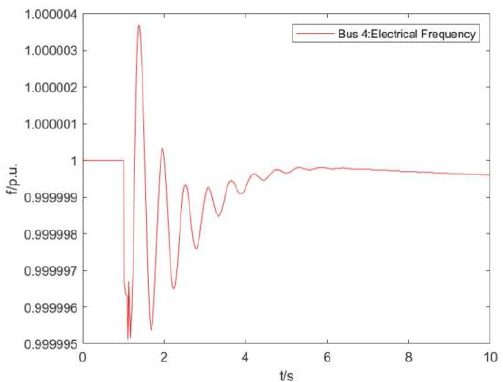
Figure 14. Frequency changes of key nodes in the system (consider VSG only).